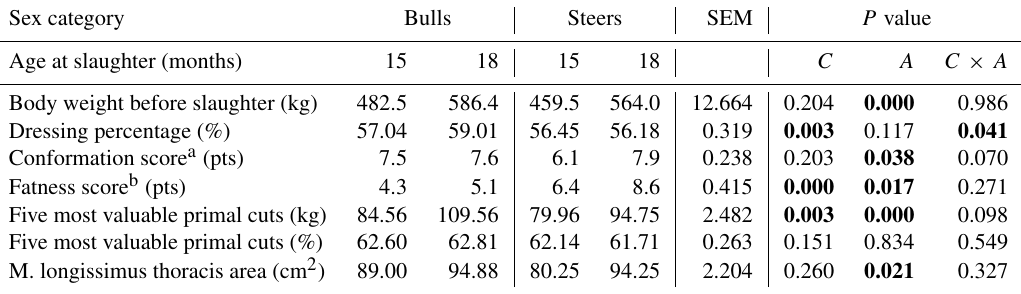
Table 2. Slaughter value of bulls and steers. Sex category Bulls Steers SEM P value Age at slaughter (months) 15 C × A Body weight before slaughter (kg) 482.5 Dressing percentage